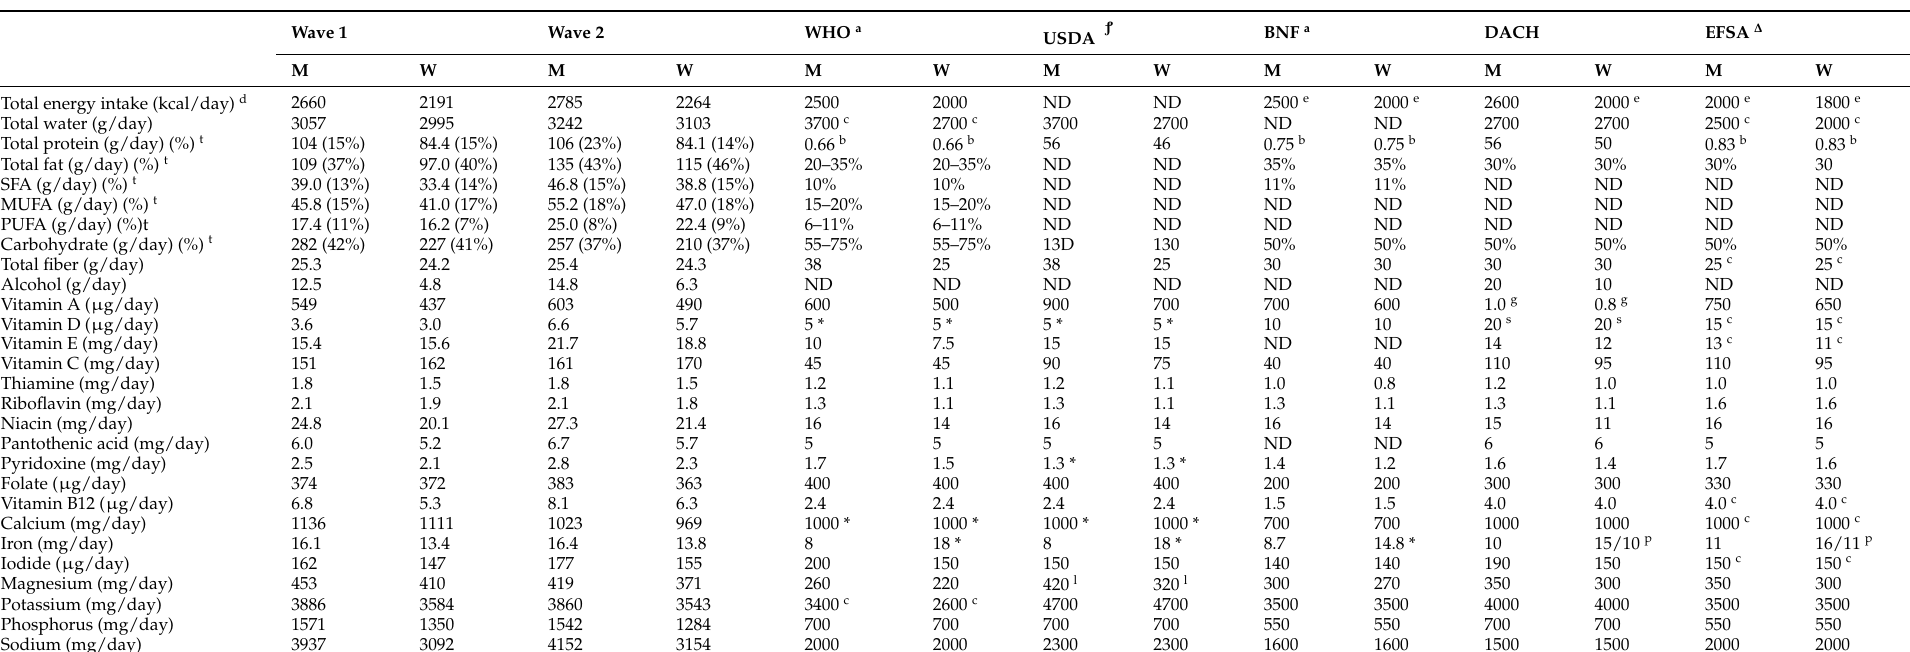
Table 7. Mean intake of macro- and micronutrients of participants in ORISCAV-LUX and ORISCAV-LUX 2 compared to recommended